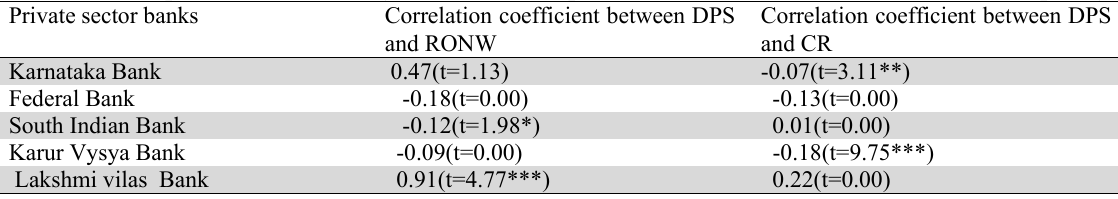
Pearson’s simple correlation analysis of dividend per share and selected factors of dividend policy